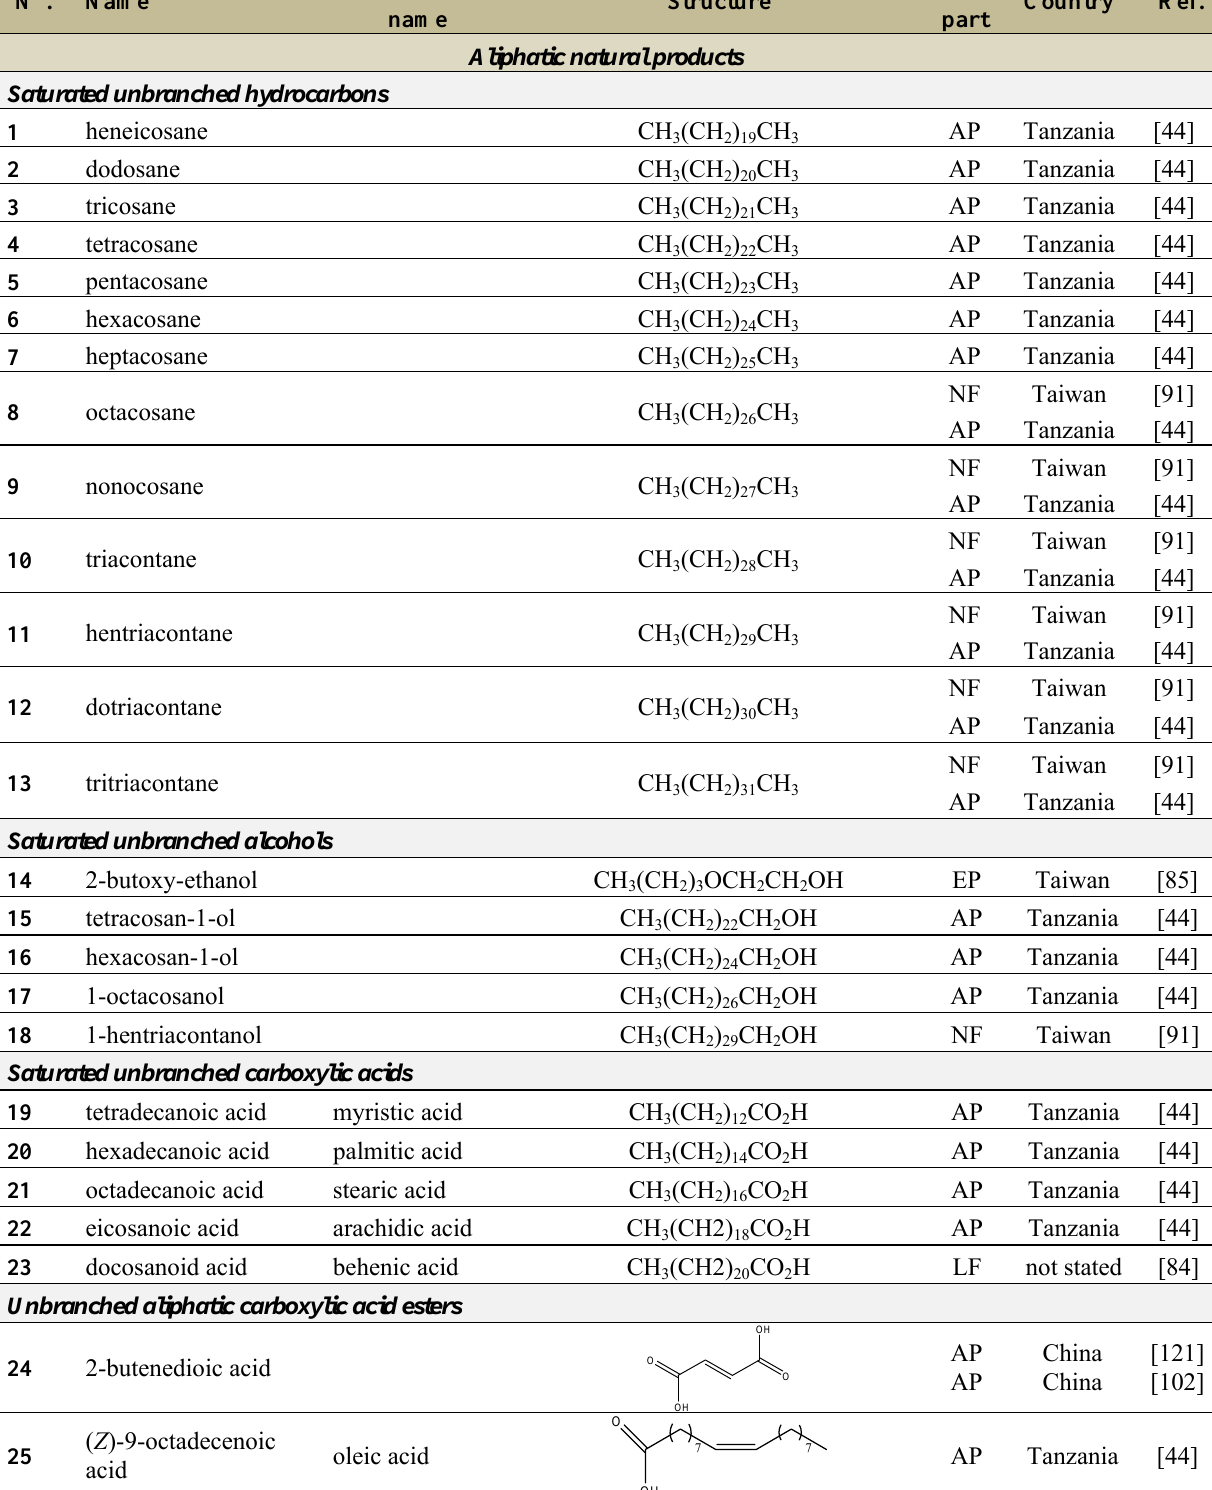
Table 1. Compounds isolated from Bidens pilosa L.